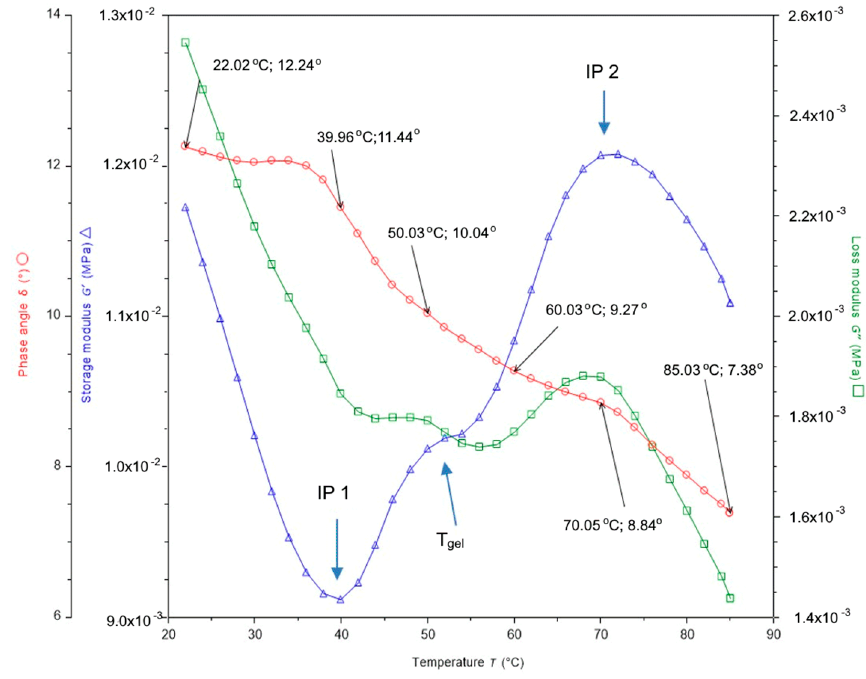
Figure 3. Changes of storage modulus (G’), loss modulus (G”), and phase shift angle ( δ ) during heating of herring meat. heating of herring